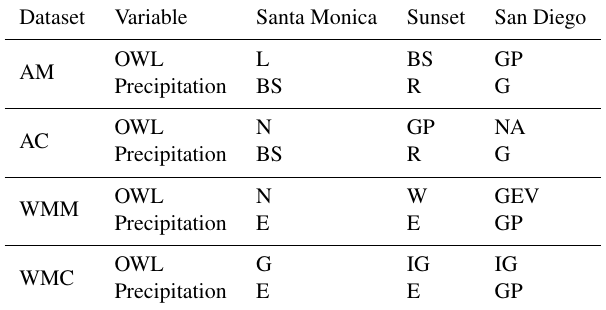
Table 4. Best-fitting univariate distributions for each location and sampling method (annual maximum, AM; annual coinciding, AC; wet-season monthly maximum, WMM; wet-season monthly coin- ciding,